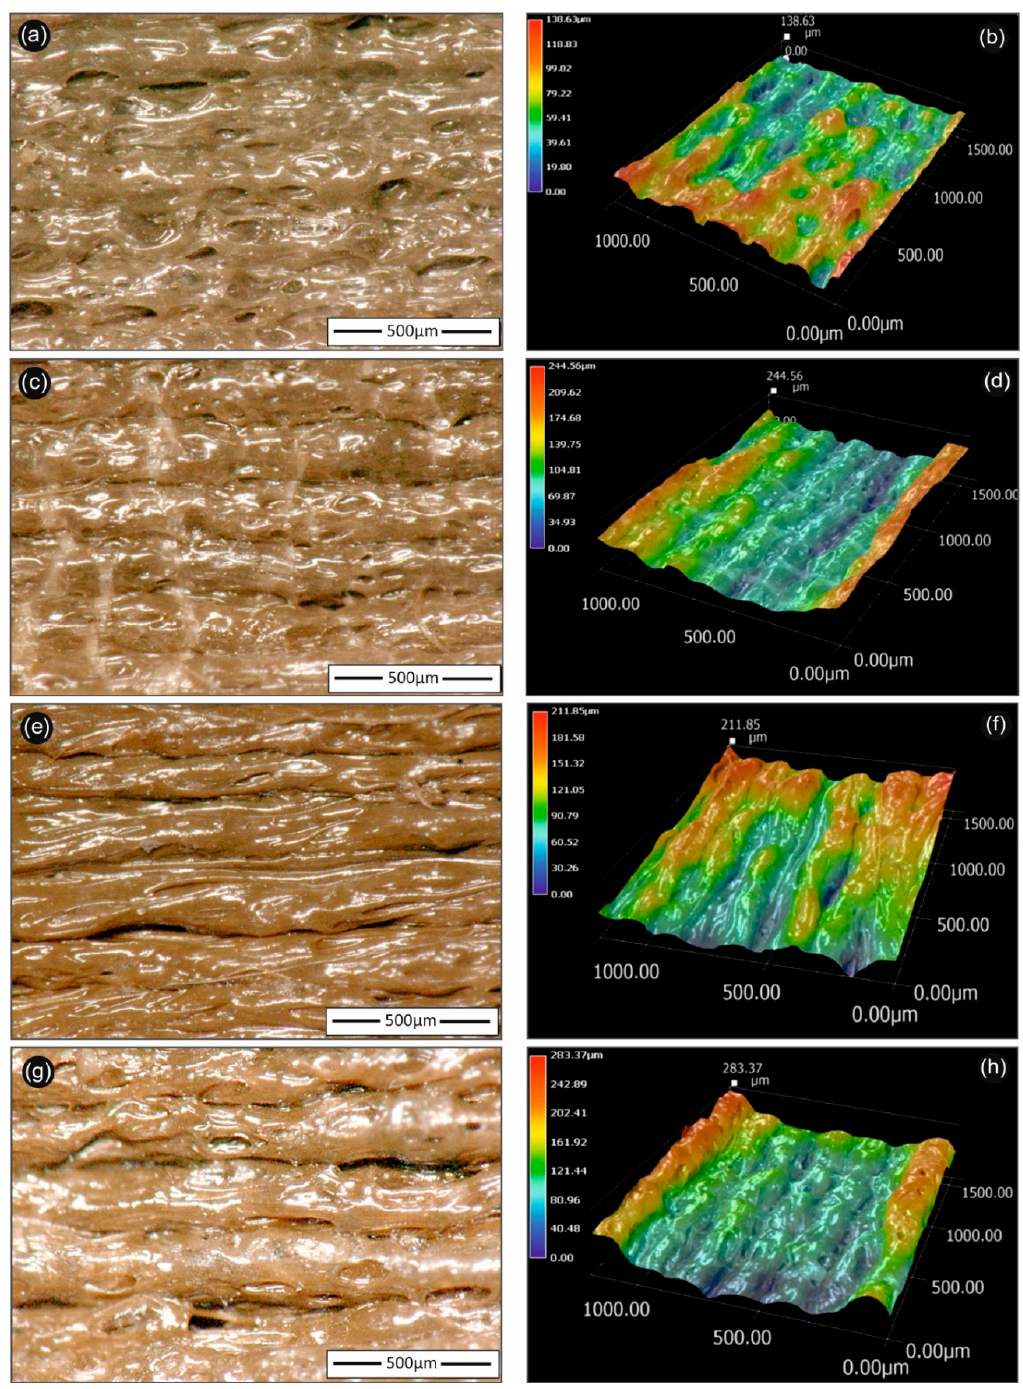
Figure 6. Optical microscopy 2D (left hand-side) and 3D (right hand-side) images of 3D printed PLA/AgNP nanocomposites (at 100 µm printed layer thickness), utilizing PLA/Ag/PEG (rec-01)—( a , b ); PLA/Ag/PEG (rec-02)—( c , d ); (PLA/Ag/PVP (rec-03)—( e , f ); and PLA/Ag/PVP (rec-04)—( g , h ) extruded nanocomposite filaments, respectively. The 500 µm scale bar is inserted and shown in each figure in the left hand-side images, while the respective 3D images are shown in the right hand-side with the corresponding color scale bar indicating the micro-roughness of each sample.